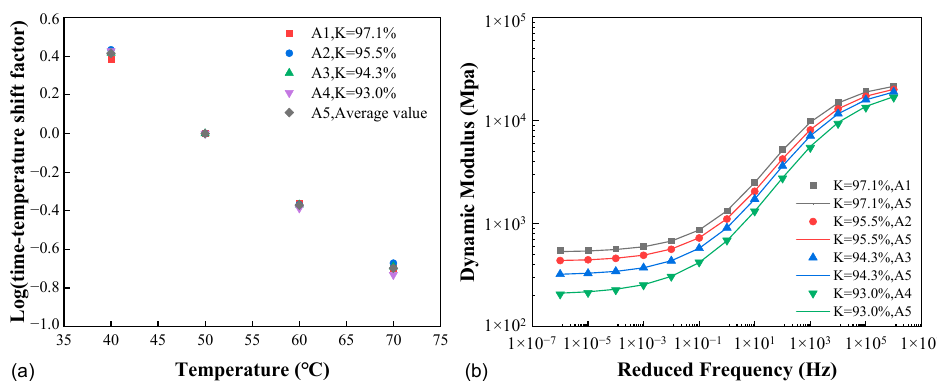
Figure 8. Comparisons between the individual and averaged shift factors ( a ) and the resulting dynamic modulus master curves ( b ).